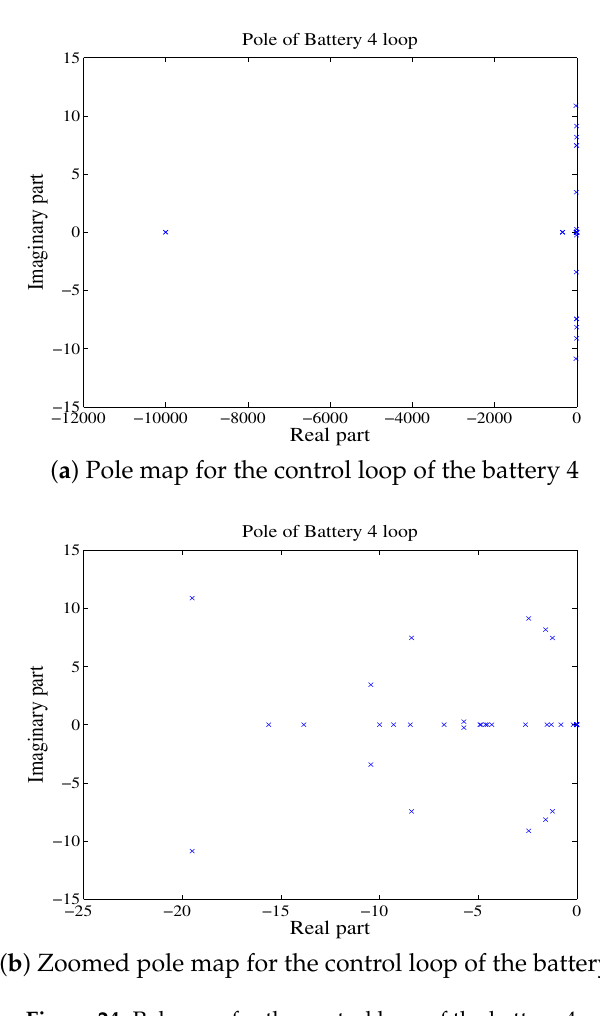
( b ) Zoomed pole map pole for the control loop of the battery 3 Figure 23. Pole map for the control loop of the battery 3.